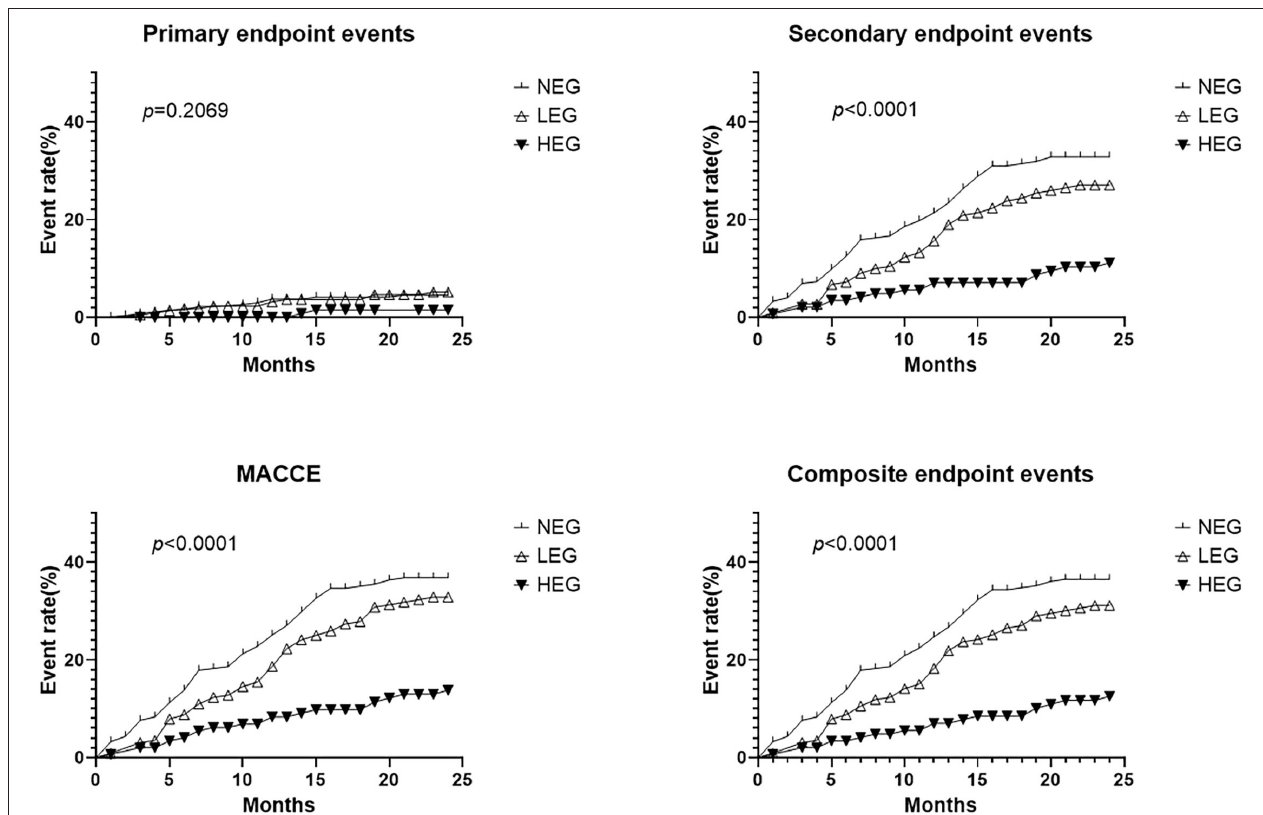
FIGURE 2 | The Kaplan–Meier survival curves of the primary endpoint events, secondary endpoint events, the major adverse cardiac and cardiovascular events (MACCE), and the composite endpoint events. The long-rank test was used to compare the survival rate between different TCM cohorts. p -value was 0.2069 for primary endpoint events and p -values were < 0.001 for secondary endpoint events, the MACCE, and the composite endpoint events, respectively. TCM, Traditional Chinese Medicine; NEG, non-exposure group; LEG, low-exposure group; HEG, high-exposure group.